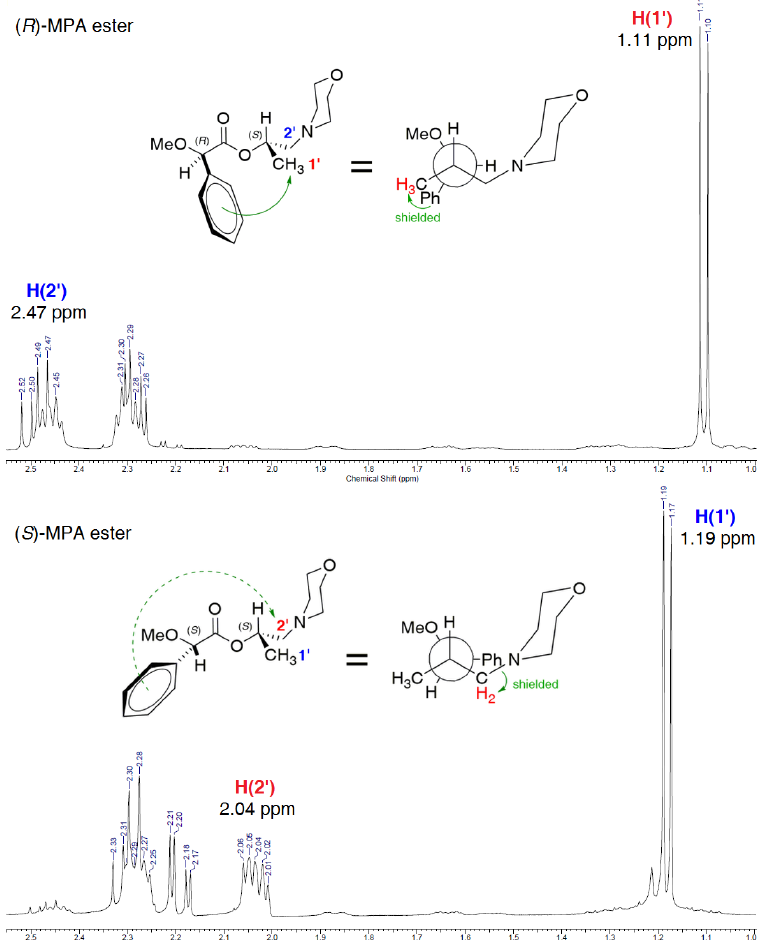
Figure 4. Partial 1 H NMR (CDCl 3 , 400 MHz) spectra of diastereoisomers ( S )-(+)- 3 -( R )- MPA (upper) and ( S )-(+)- 3 -( S )- MPA (bottom) derived from enantiomerically pure alcohol (+)- 3 (>99% ee) of an unknown absolute configuration. With red color are marked protons of alcohol fragment (+)- 3 shielded by the phenyl substituent of chiral auxiliary MPA ; blue labels stand for unaffected (deshielded) protons. Green arrows indicate the shielding effect caused by π -electron-rich aromatic system.